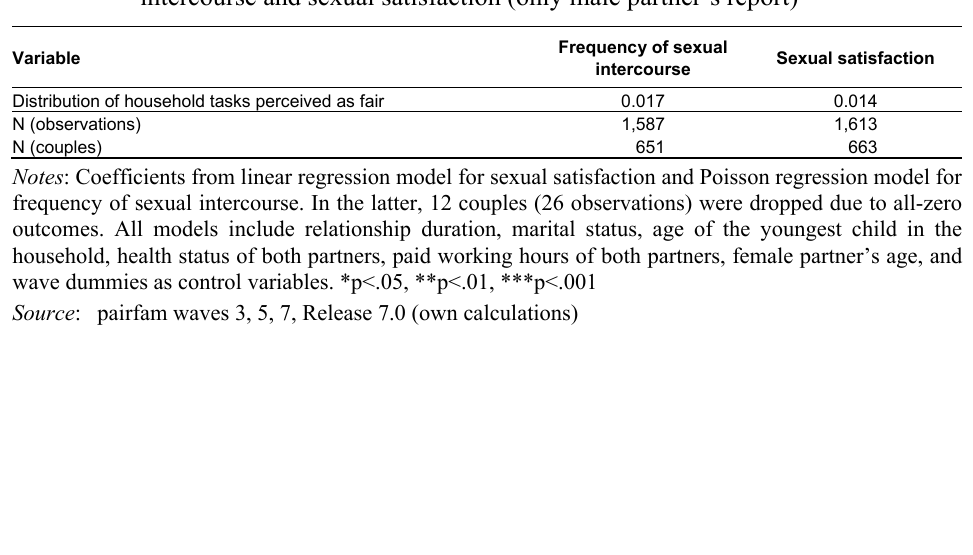
Table A.12 : Summary of fixed effects regression analyses estimating frequency of sexual intercourse and sexual satisfaction (only male partner’s